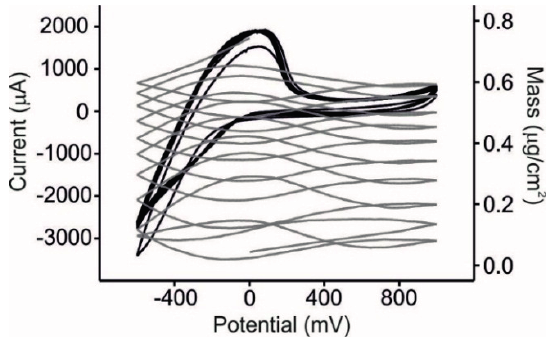
Figure 4. Voltammetric (black line) and mass (grey line) response of the NiPc SO3 /PAH sensor towards a must obtained from Juan García grapes.